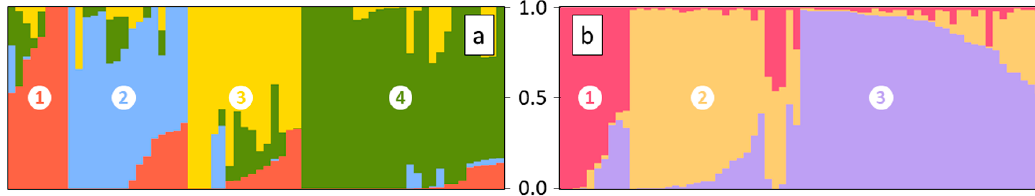
Figure 2. Genetic structure of the grapevine rootstock core collection (66 genotypes), defined using 14k SNP ( a ) and 17 SSR ( b ) molecular markers. Ancestral groups (1, 2, 3, and 4 for SNP and 1, 2, and 3 for SSR) are reported in different colors.